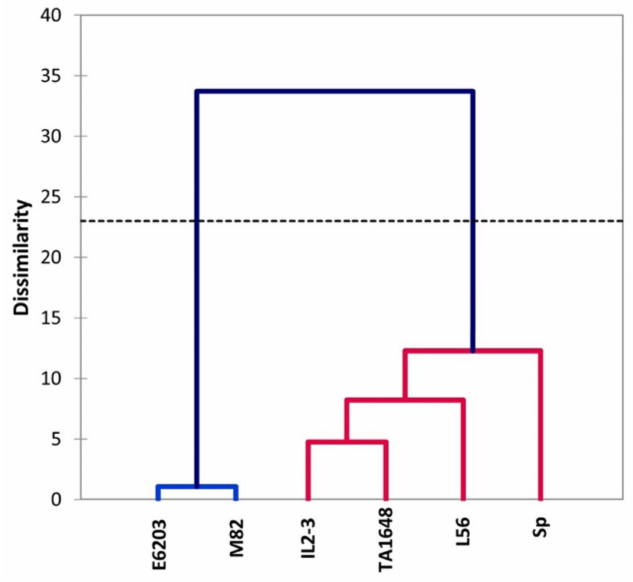
Figure 7. Hierarchical cluster analysis of two ILs (TA1648 and IL2-3), the cultivar parents (cv. E6203 and M82) and two salt-tolerant reference genotypes, “SP” (wild type) and “L56” (fixed variety) for salt tolerance indices based on physiological parameters analysis at the vegetative stage grown under control and salt stress condition (120 mM). The dendrography was drawn by Ward’s method in XLSTAT